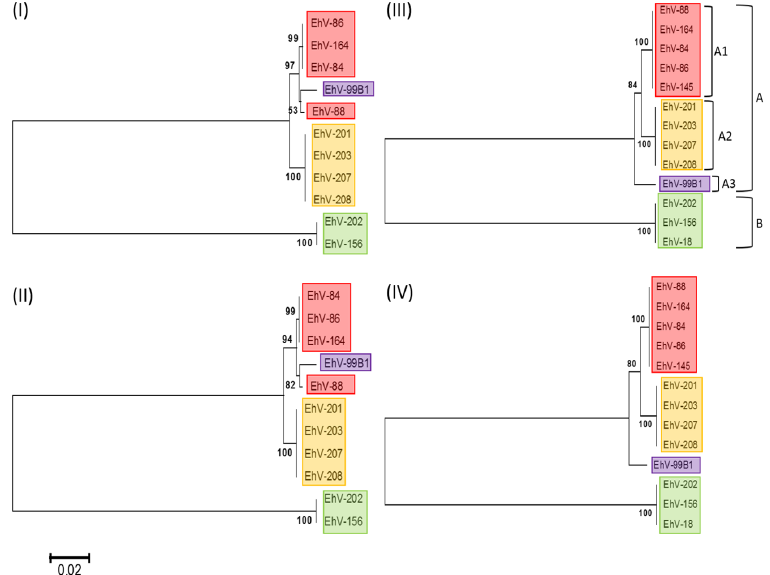
Figure 1. Phylogenetic analysis of coccolithoviruses based on their DNA polymerase and serine palmitoyltransferase (SPT) genes. The evolutionary history of 13 EhV strains was inferred based on the 2604 bp long SPT (I and II) and 2921 bp long DNA polymerase (III and IV) genes, using the Neighbor-Joining (I and III) and Maximum Likelihood (II and IV) methods. Note that EhV-18 and EhV-145 are absent from the serine palmitoyltransferase tree due to the full length SPT protein being split over two separate genes in their respective genomes. Based on the DNA polymerase phylogeny, the EhVs cluster into two main clades: A and B (green). Clade A is further divided into sub-clusters A1 (red), A2 (yellow), and A3 (purple). The percentage of replicate trees in which the associated taxa clustered together in the bootstrap test (1000 replicates) are shown next to the branches. The evolutionary distances were computed using the Tamura-Nei method and are in the units of the number of base substitutions per